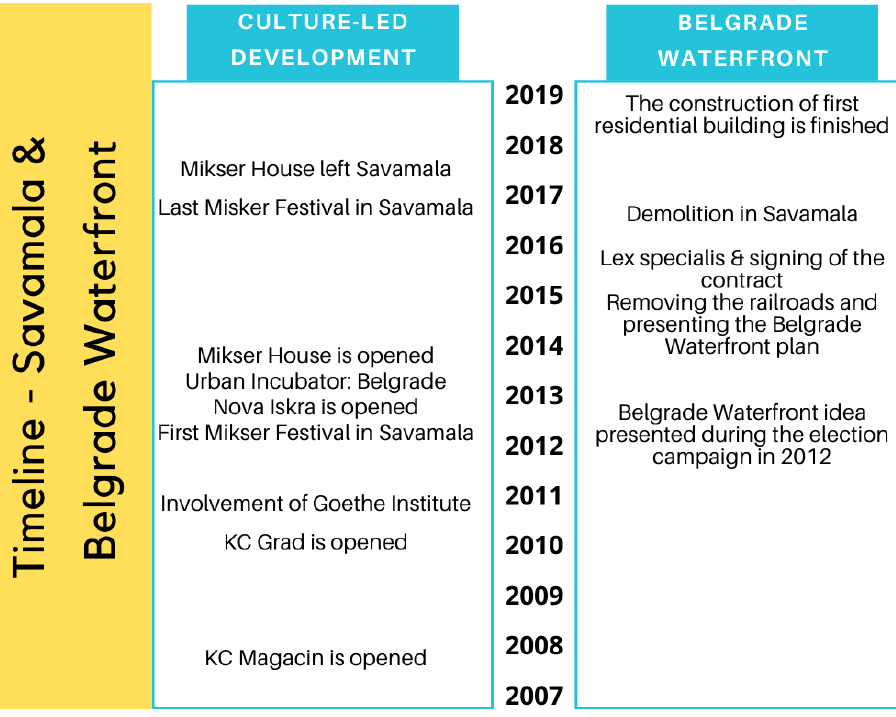
Figure A2. Important occasions in the cultural-led development of Savamala, as well as on the Belgrade Waterfront.